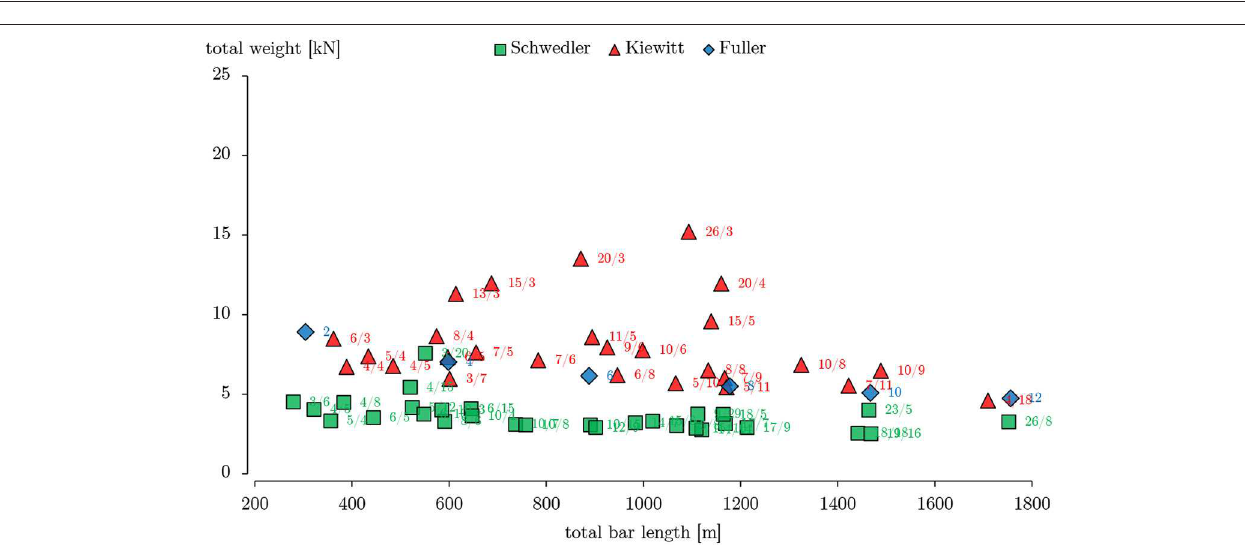
FIGURE 6 | Optimized design (top) and member forces (bottom) of (A) the Schwedler dome, (B) the Kiewitt dome, and (C) the geodesic dome if each member is sized individually. Compressive member forces are shown in red, tensile member forces in blue.